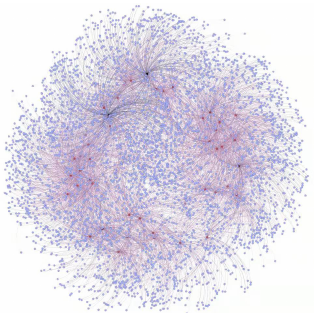
Fig. 1 Nodes and edges in social network.